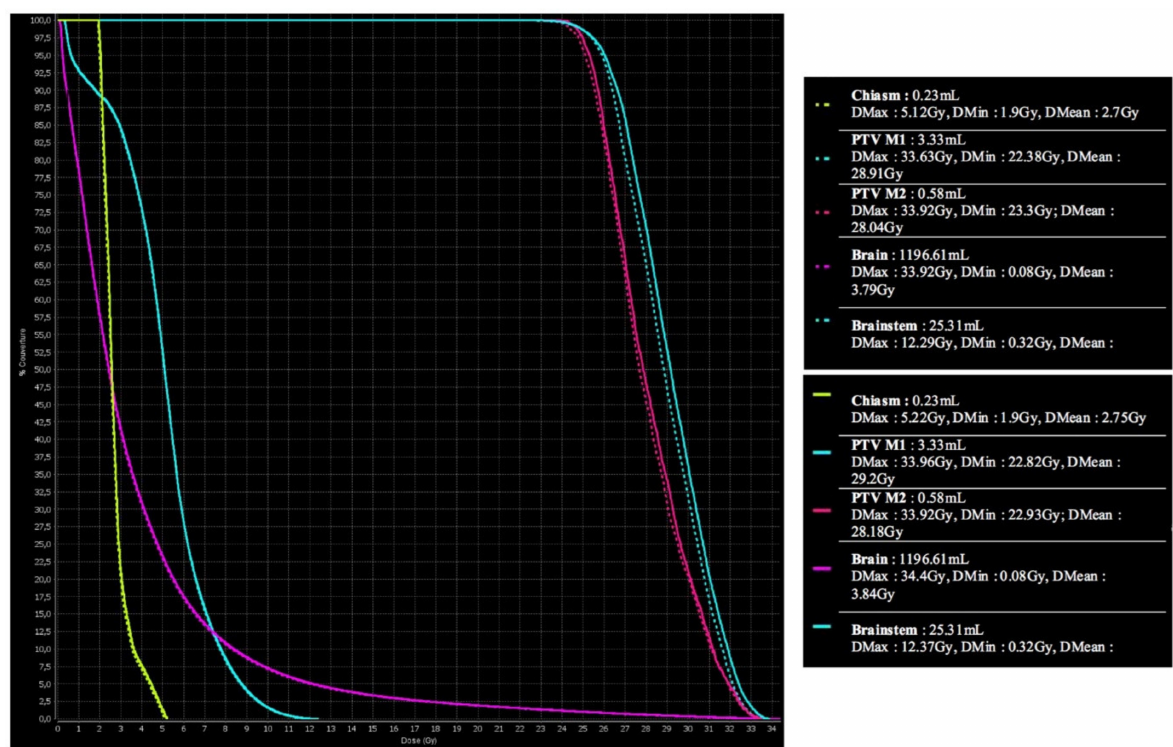
Figure 2. DVH comparison between the initial dose map (top) and the synthetic dose map (bottom). Abbreviations: PTV: planning target volume, M1: metastasis 1, M2: metastasis 2, Dmax: maximum dose, DMin: minimum dose, Dmean: mean